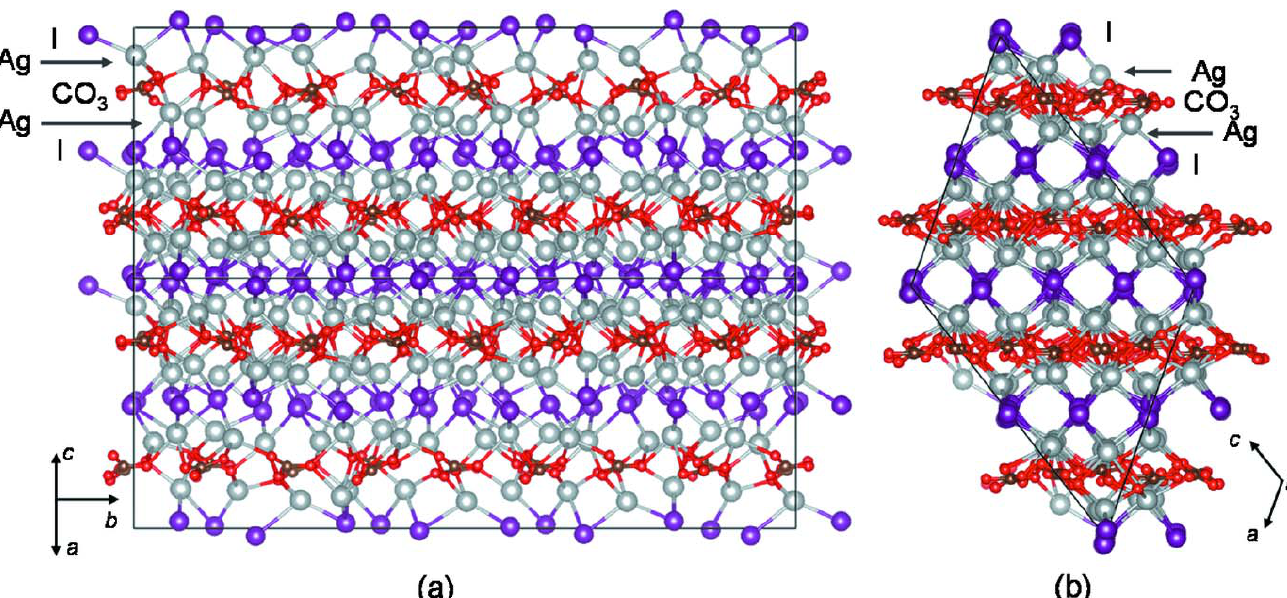
Figure 2 Projections of the crystal structure of Ag 10 (CO 3 ) 3 I 4 along [101] ( a ) and [010] ( b